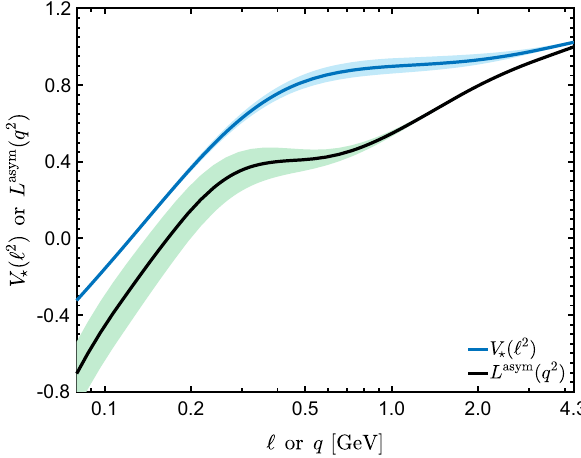
Fig. 6 The propagation of the uncertainty in the L asym ( q 2 ) to the V (cid:20) ((cid:7) 2 ) , through the action of the sum rule